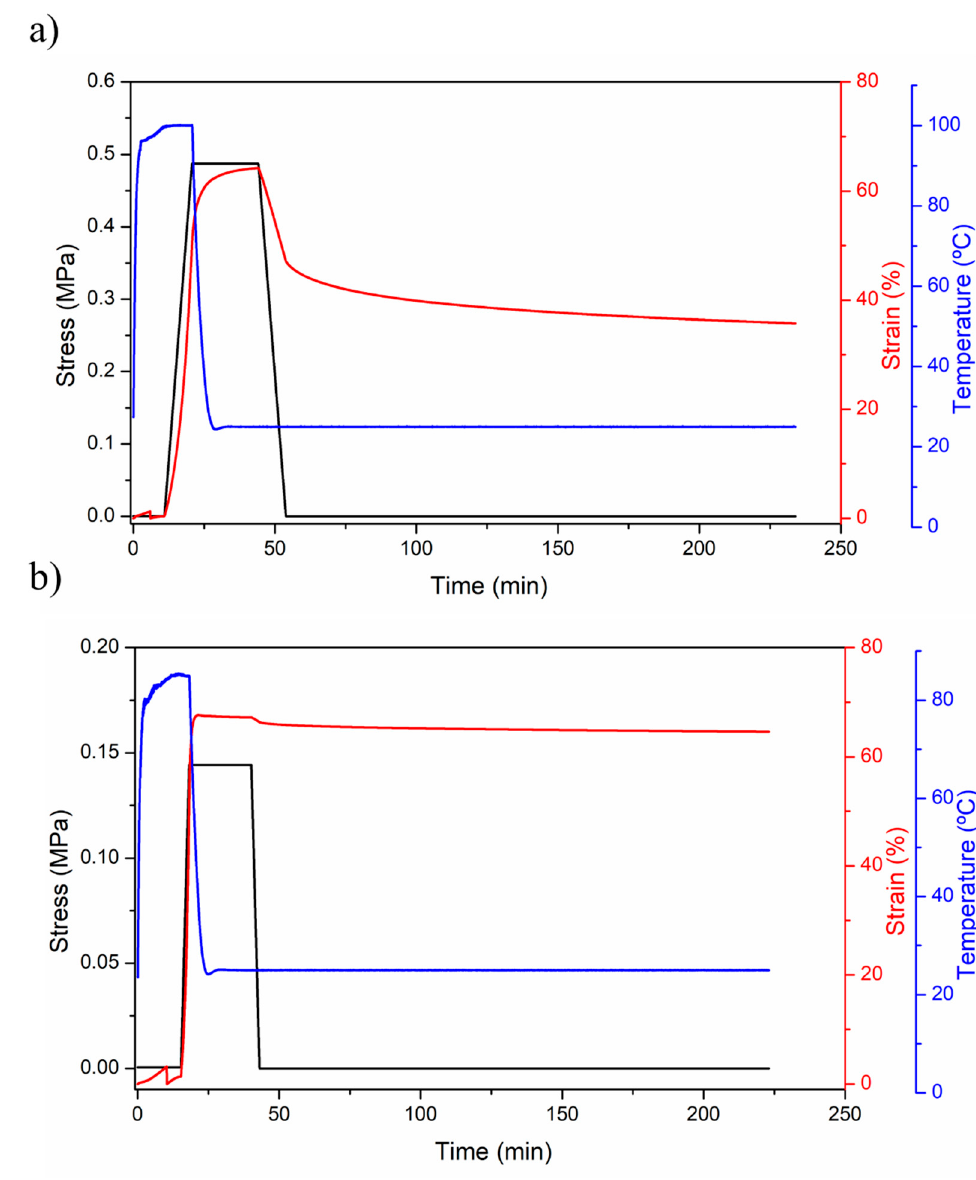
Figure 8. Two-dimensional stress–strain–temperature diagrams as a function of time for ( a ) PUPCL531 and ( b ) PUPCL2054. Table 3. R r and R f values calculated for all the cycles of both materials. The energy efficiency values, defined as the ratio between the real and ideal values, are also